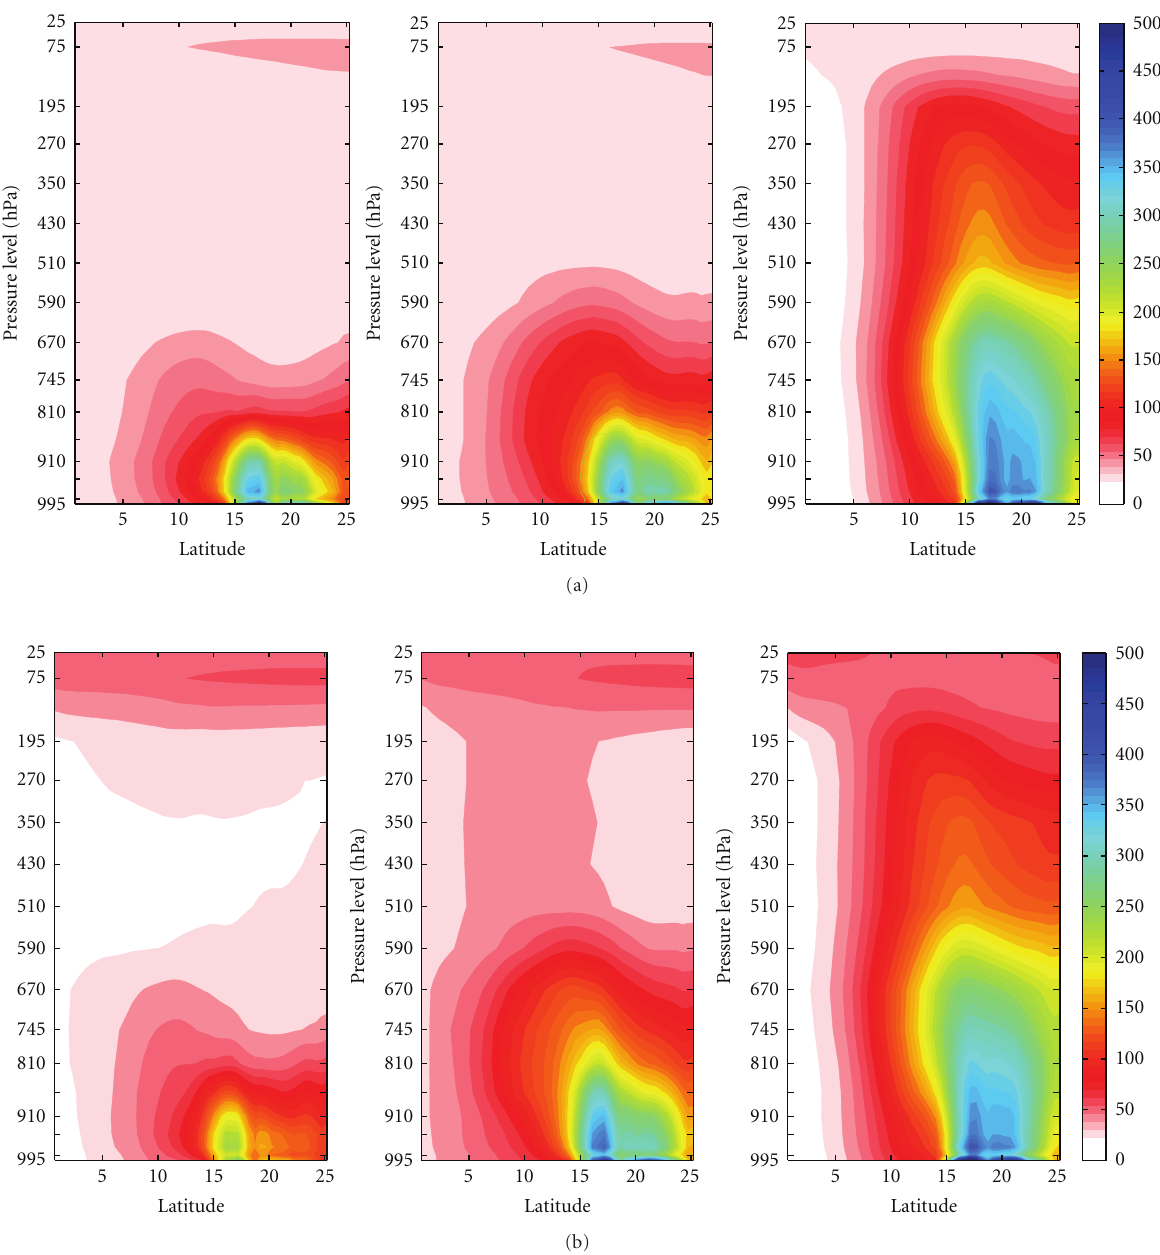
Figure 8: Meridian profile of mean desert dust concentrations in μ g/kg average between 66 ◦ W and 23 ◦ E for the periods “December-January- February (DJF),” “March-April-May (MAM),” and “June-July-August (JJA)”: (a) mean values for the years 2005–2010; (b) mean values for 2010. Higher concentrations are indicated with cool colors and lower concentrations with hot